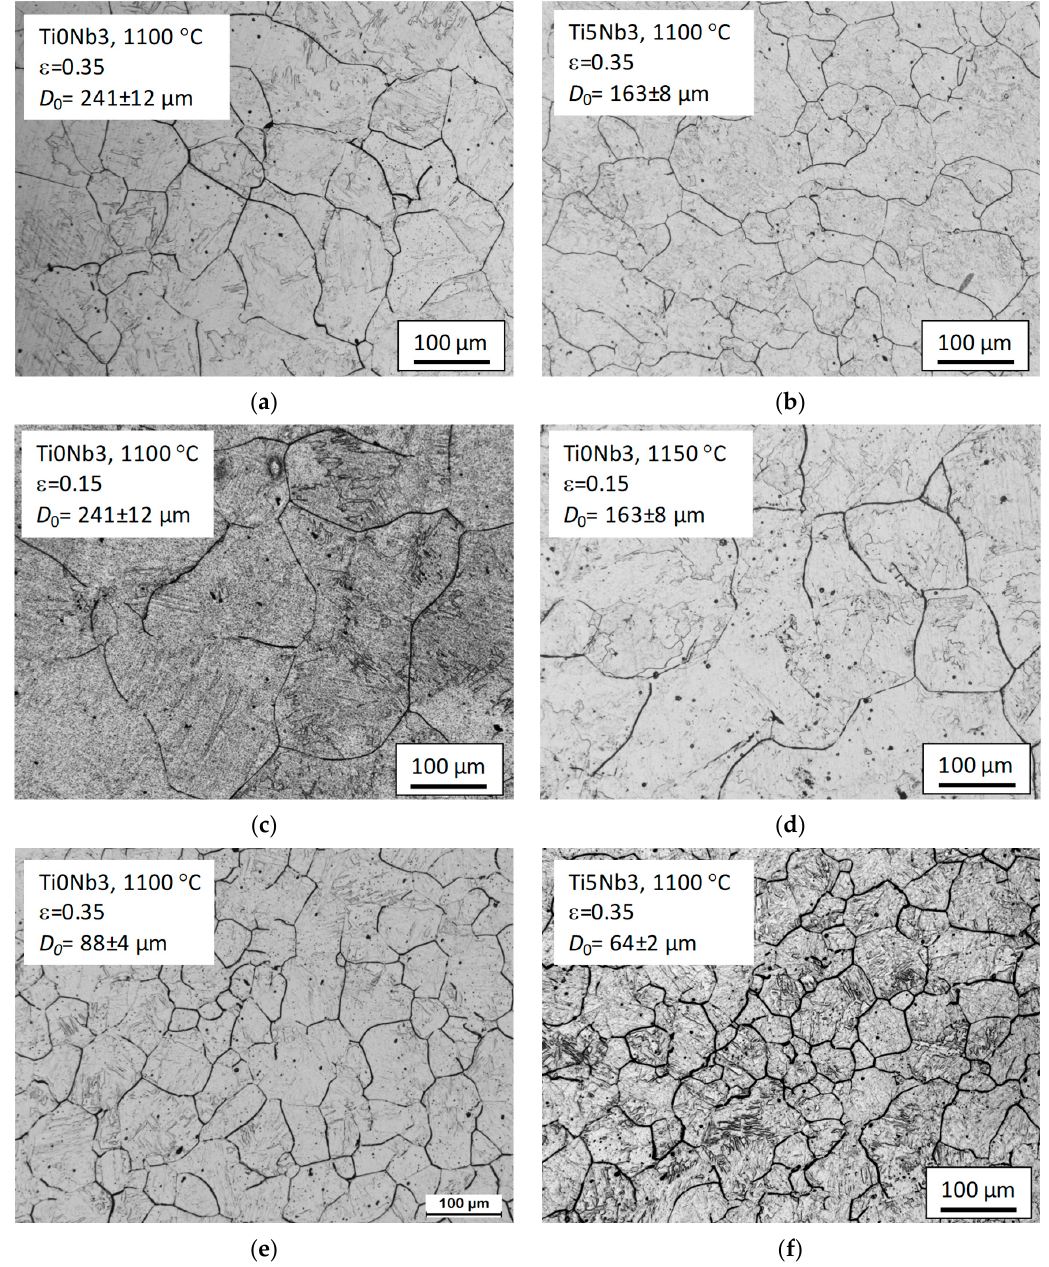
Figure 13. Examples of recrystallized austenite microstructures obtained at different deformation conditions. ( a ) 𝑑 (cid:3020)(cid:3019)(cid:3025) = 88 ± 4 µm, ( b ) 𝑑 (cid:3020)(cid:3019)(cid:3025) = 70 ± 2 µm, ( c ) 𝑑 (cid:3020)(cid:3019)(cid:3025) = 256 ± 4 µm, ( d ) 𝑑 (cid:3020)(cid:3019)(cid:3025) = 162 ± 9 µm, ( e ) 𝑑 (cid:3020)(cid:3019)(cid:3025) = 65 ± 4 µm, ( f ) 𝑑 (cid:3020)(cid:3019)(cid:3025) = 56 ± 1 µm.